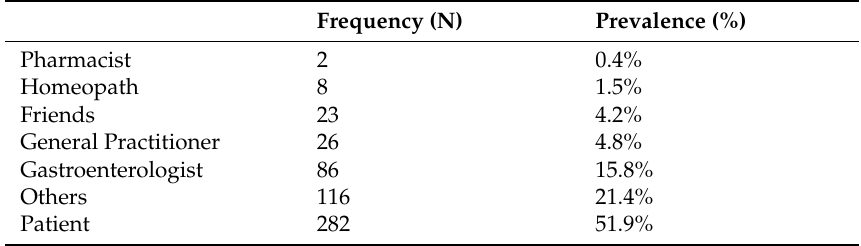
Table 1. Individuals who initially suspected the possible existence of NCGS: frequency and prevalence of the 543